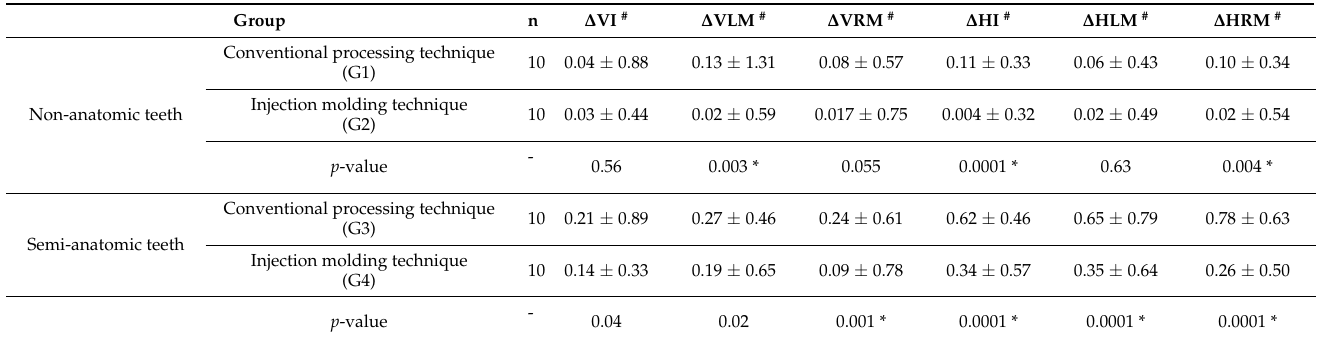
Table 2. Mean, standard deviation (linear change in dimension in mm) and intergroup comparison with respect to non-anatomic and semi-anatomic processing groups.